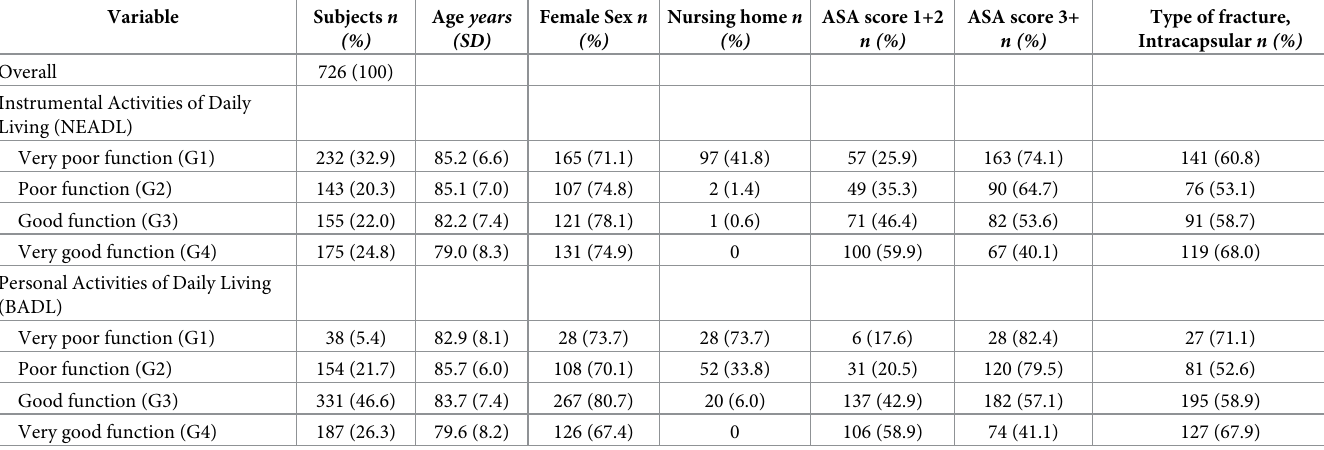
Table 3. Characteristics of patients according to